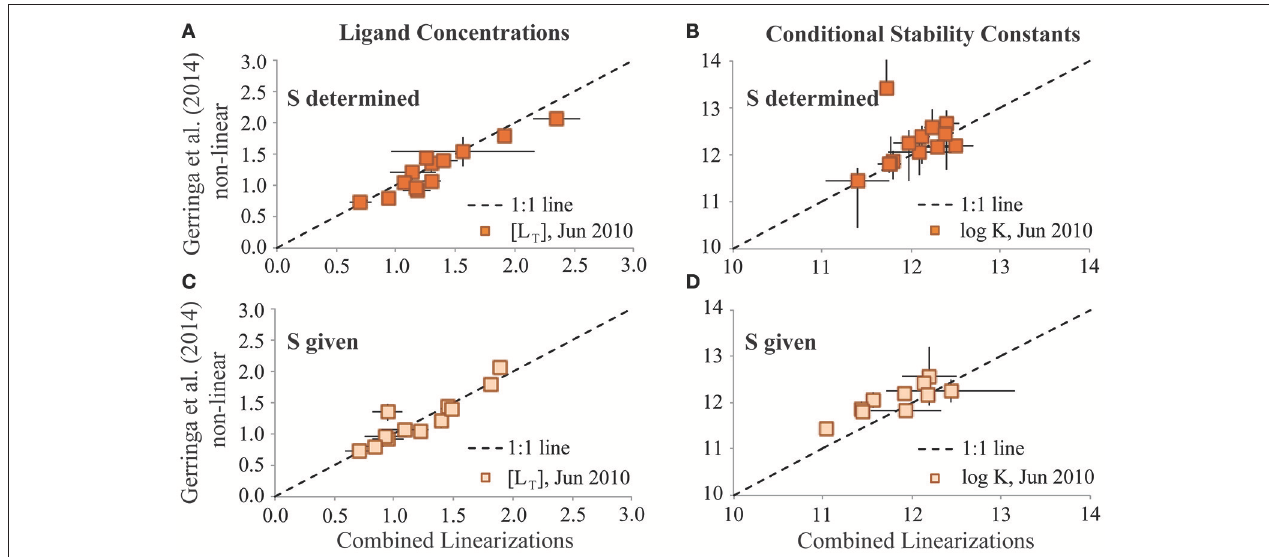
FIGURE 3 | Results of the single ligand class reinterpretation exercises of the GA02 (June 2010) dataset for ligand concentrations ( A,C ; units: nM Eq Fe) and log conditional stability constants ( B,D ; units of K: M − 1 ). Results from the Combined Linearization approach to data interpretation are plotted on the x-axes vs. the results from the Gerringa et al. (2014) non-linear data interpretation approach on the y-axes. Upper panels depict results from when the sensitivity parameter (S) was determined in the reinterpretation exercise. Lower panels depict results of the reinterpretation exercise from when the S parameter was given by the original